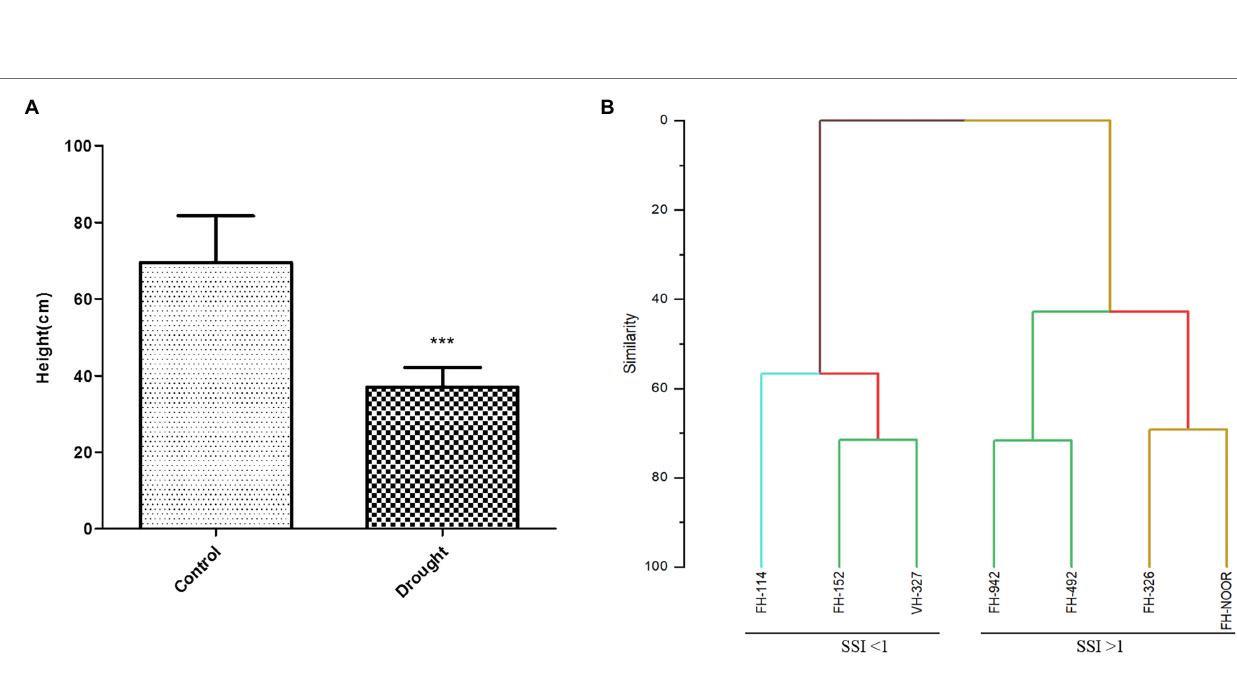
FIGURE 2 | Effect of drought stress on the shoot length of cultivated varieties of Gossypium hirsutum . Bar heights represent the average of replicated values and error bars represent standard deviation (A) , sorting of cotton varieties on the basis of stress susceptibility index (B) .